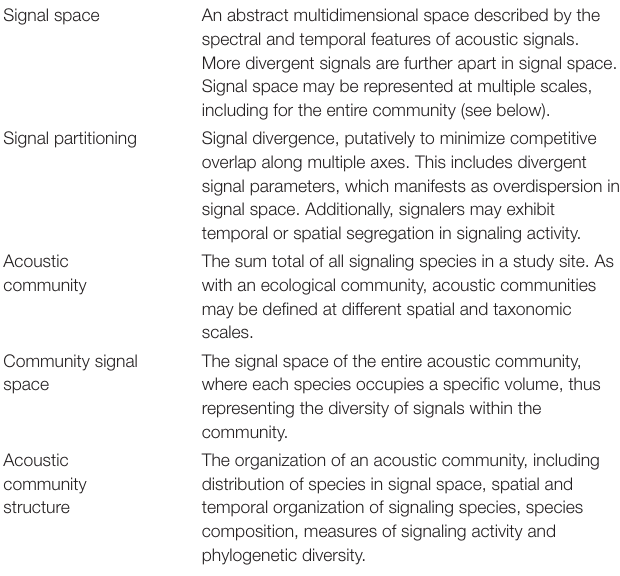
TABLE 1 | Definitions and discussion of important terms related to community bioacoustics. Signal space